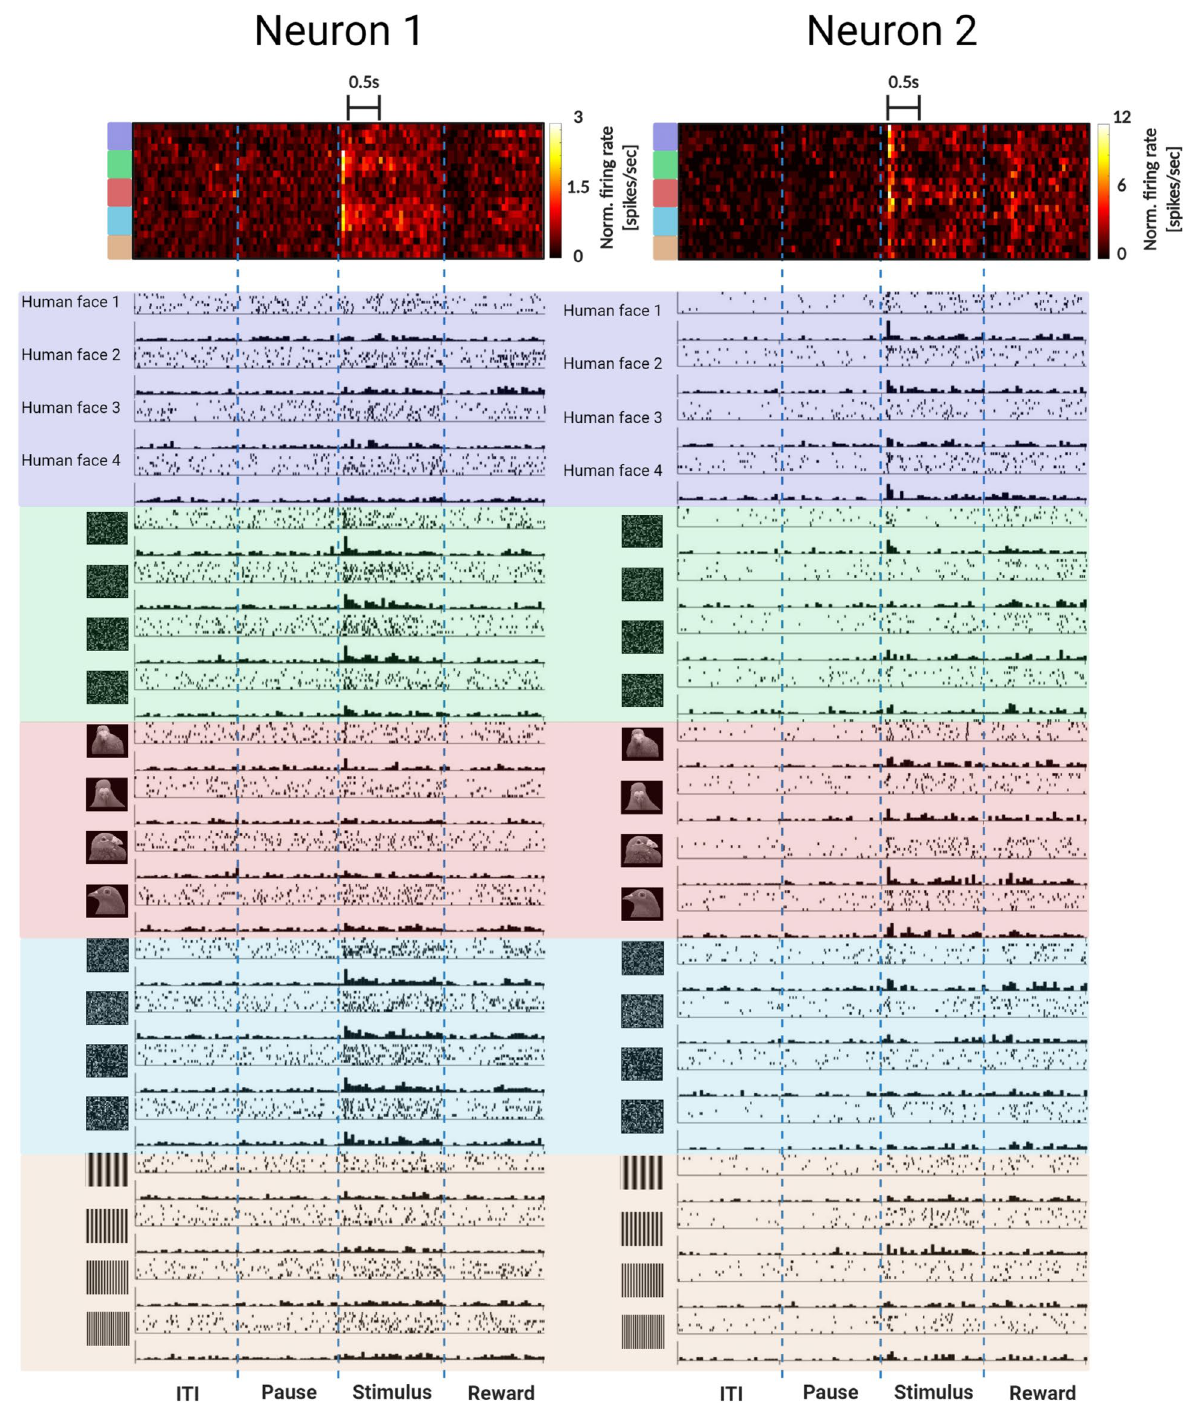
Figure 5. Examples of neurons that responded best to scrambled and face images. Two example MVL stimulus- selective neurons that responded best to scrambled human/pigeon faces (left) and pigeon/human faces (right). Scrambled images were created using open access Webmorph software (https:// fei. edu. br/ ~cet/ faced ataba se. html): Lisa DeBruine. Webmorph (Beta Release 2). Zenodo (2018). https:// doi. org/ 10. 5281/ zenodo. 10736 96. Human face images not shown due to copyright